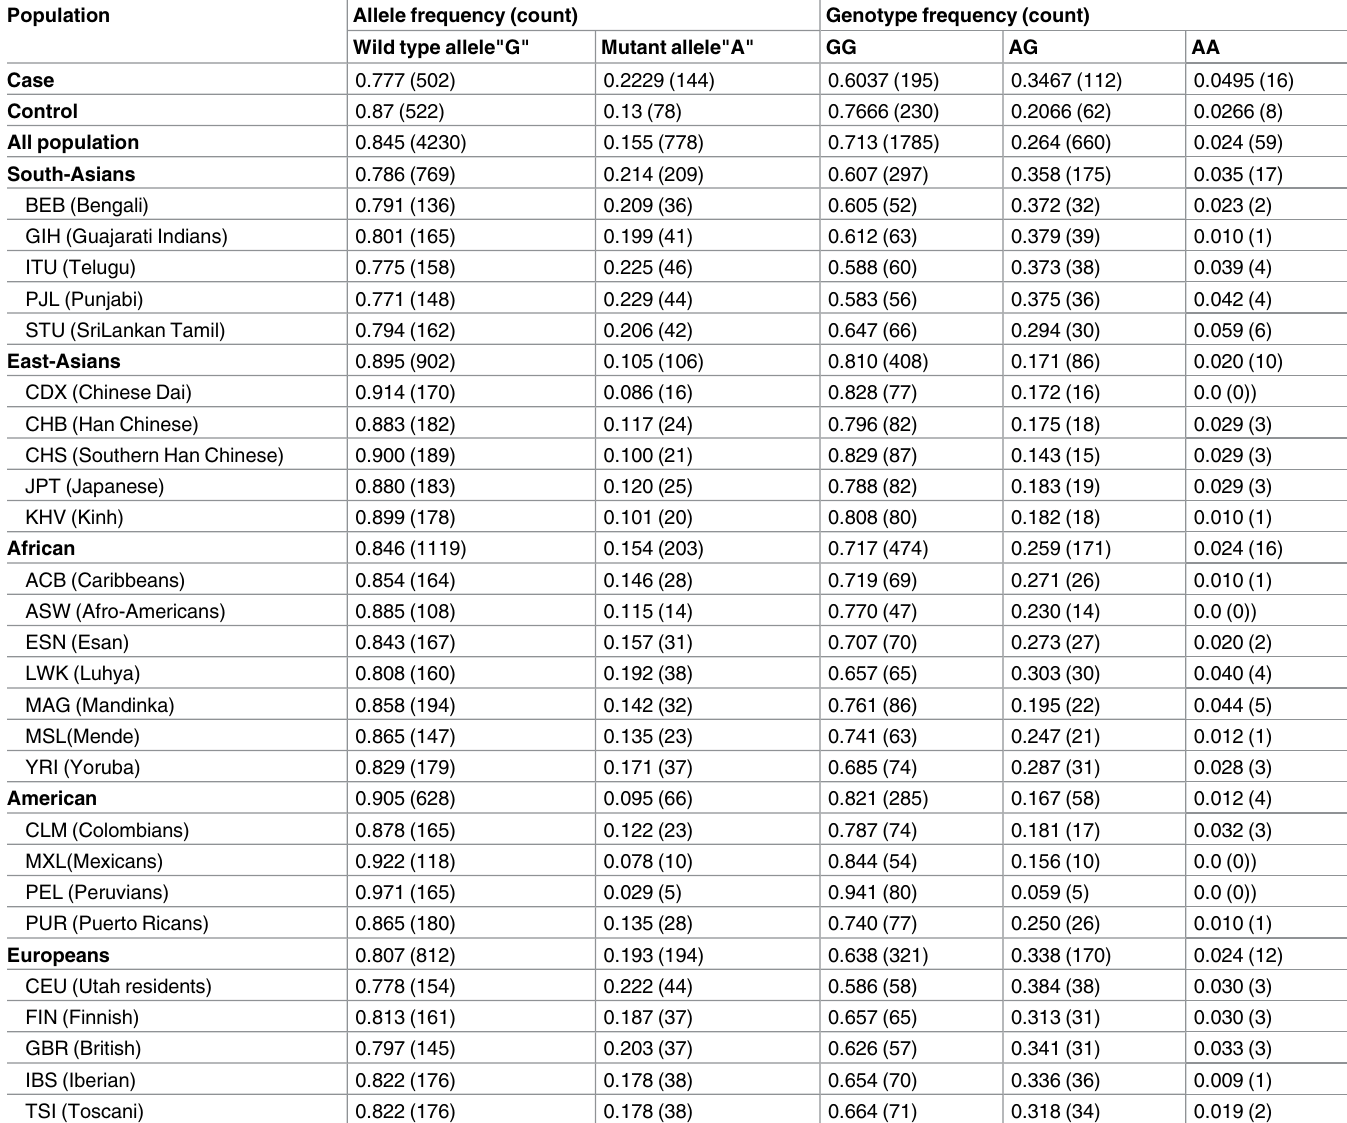
Table 5. Frequency spectrum of allele and genotype of rs1801706/c. * 84G > A in case, control and different world populations. Population Allele frequency